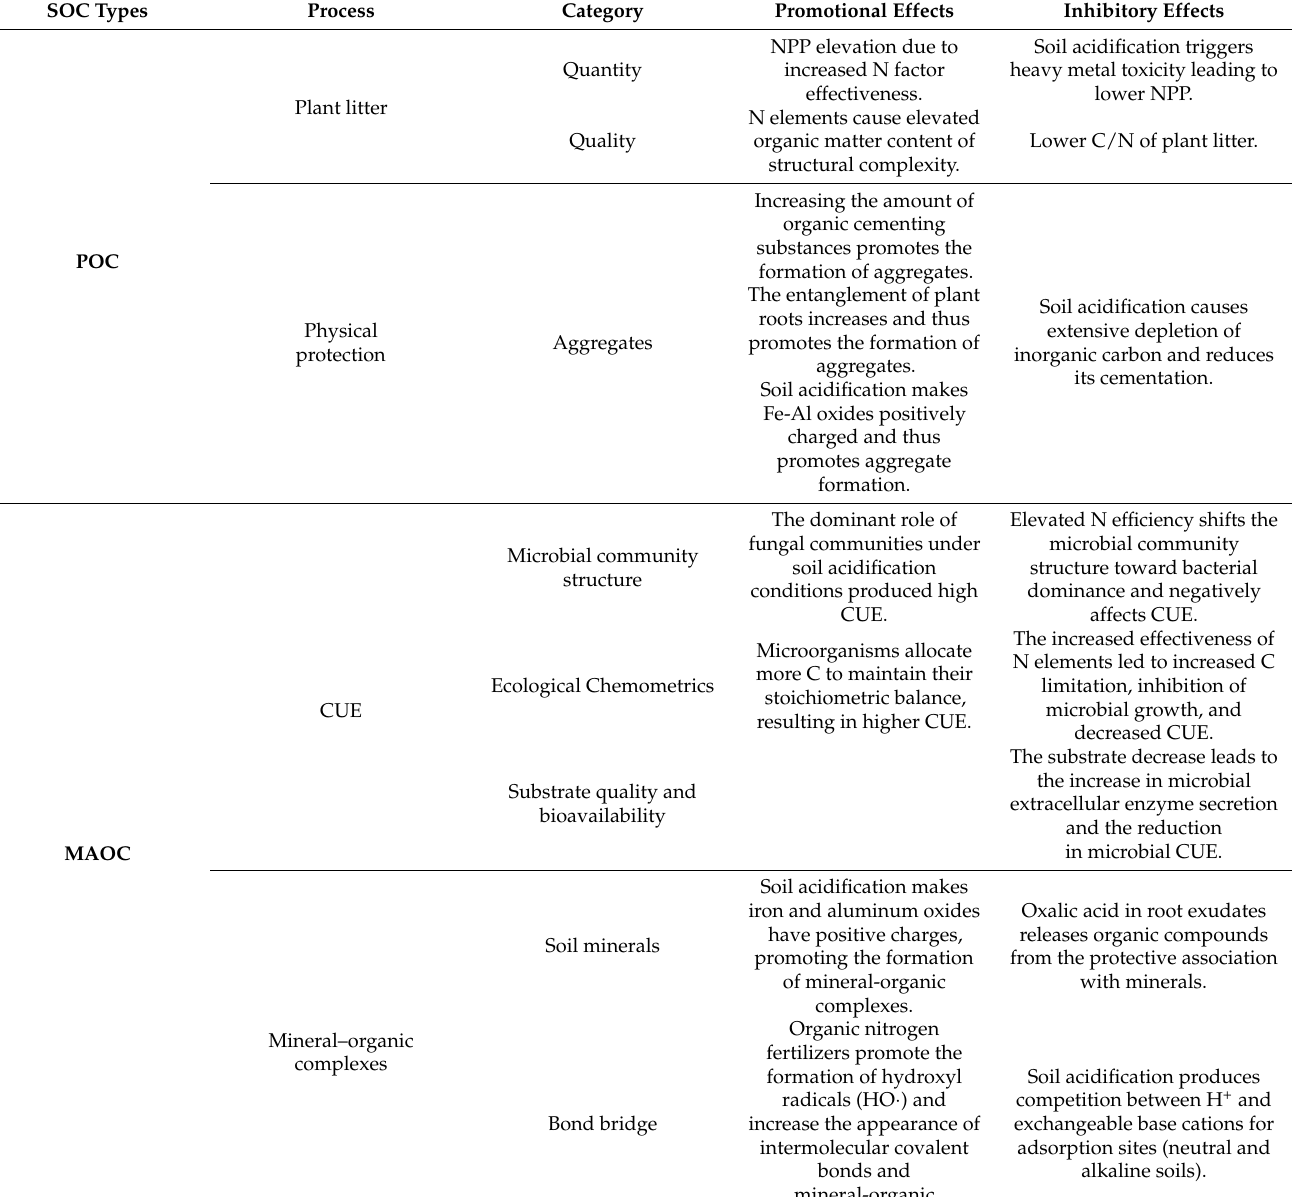
Table 1. Effect of nitrogen on the turnover process of POC and